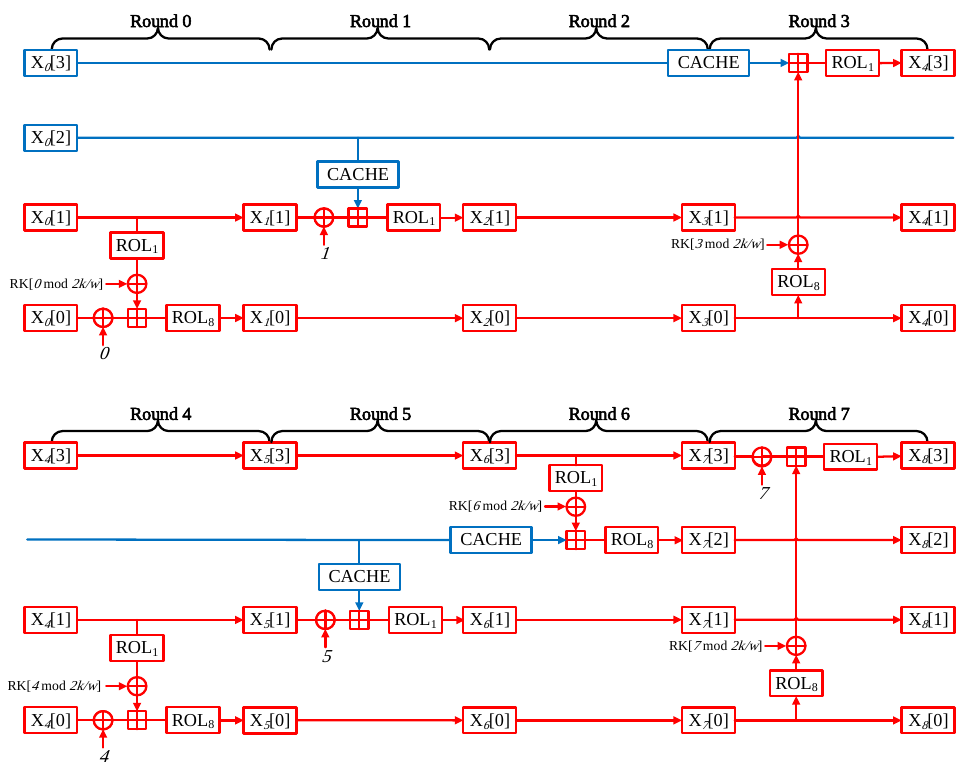
Figure 3. The counter value flow of 32-bit counter